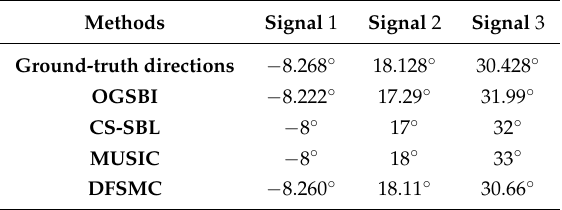
Figure 7. The estimation error with iterations ( α c = − 5 dB). Table 3. Estimated directions ( α c = − 5